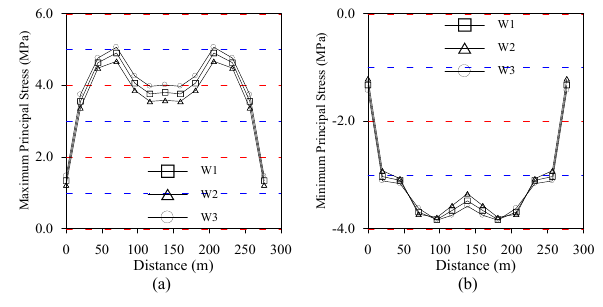
(b) Fig. 18. The maximum (a) and minimum (b) stresses at section I-I of arch dam for Case W. The time histories of maximum principal stresses (tensile stress) at nodal point 48, which is the most representative crest point of downstream side of the dam, for each case are plotted by displaying the demand-capacity ratios (DCR) in Fig. 19 (a-c). It is clearly seen from Fig. 19 that some values of maximum principal stresses are over than DCR=1 for all cases. It means that the maximum principal stresses occurred on the dam are much more than tensile strength of concrete used in dam body. Fig. 20. Performance curves at nodal point 48 of the arch dam for Case W1, W2, and W3.